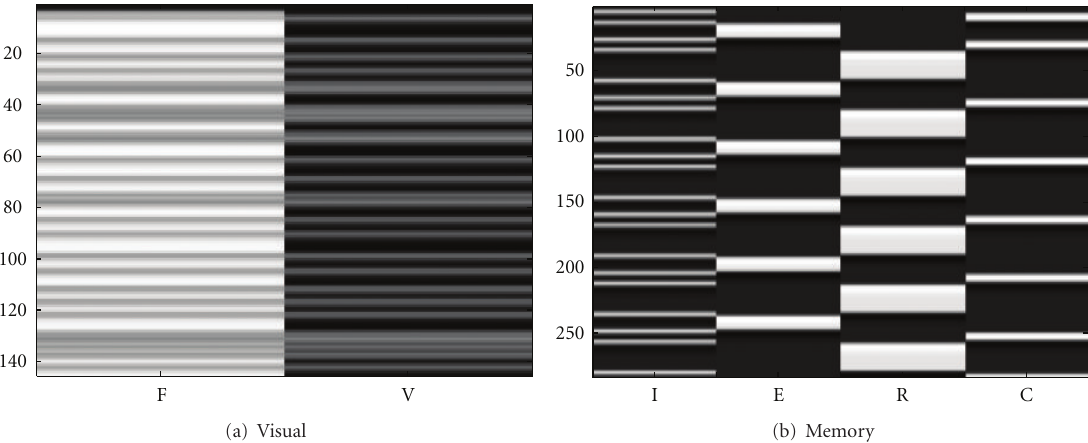
Figure 1: Design matrices for visual (a) and memory (b) paradigms. From left to right, the regressors are fixation (F) and visual activation (V) for the visual paradigm (a), and instruction (I), encoding (E), recognition (R), and control (C) for the memory paradigm (b). The SPM- type two-gamma function was used as the HRF. Note that with centered data, (a) can be modeled by a single centered activation column and (b) can be modeled by three centered columns. The redundant presentation was used to show all experimental